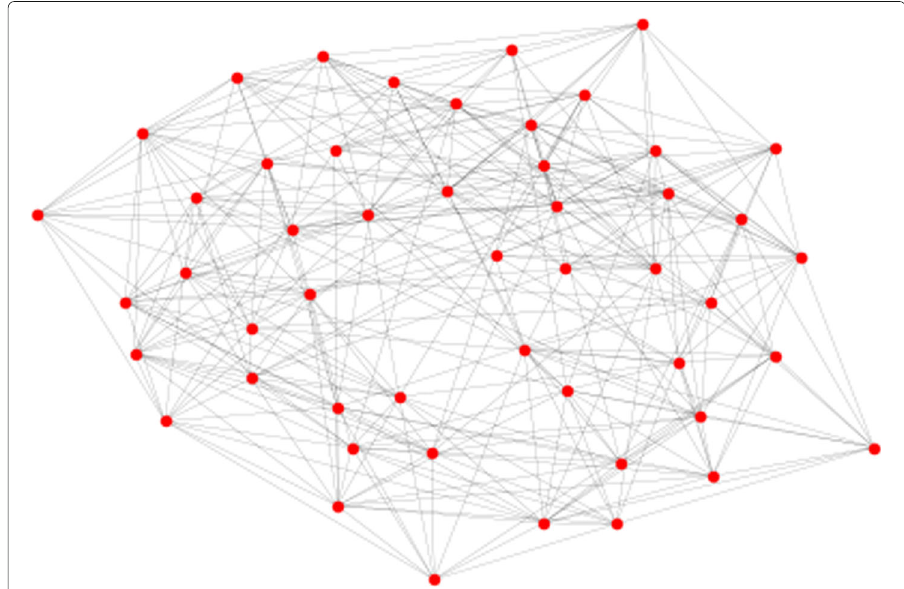
Cascade generation: We learn the diffusion influence weights from mining historical diffusion cascades. Here, we generate the cascades for the synthetic data. We randomly select a set of seed nodes accounting for 35% of total nodes . Then the seed nodes could propagate the information to other nodes. Here we assume the active nodes will remain active and the inactive nodes will have the chances to be activated only when they have connections to active nodes within 2 step neighborhood. The activation probability p for target node is defined